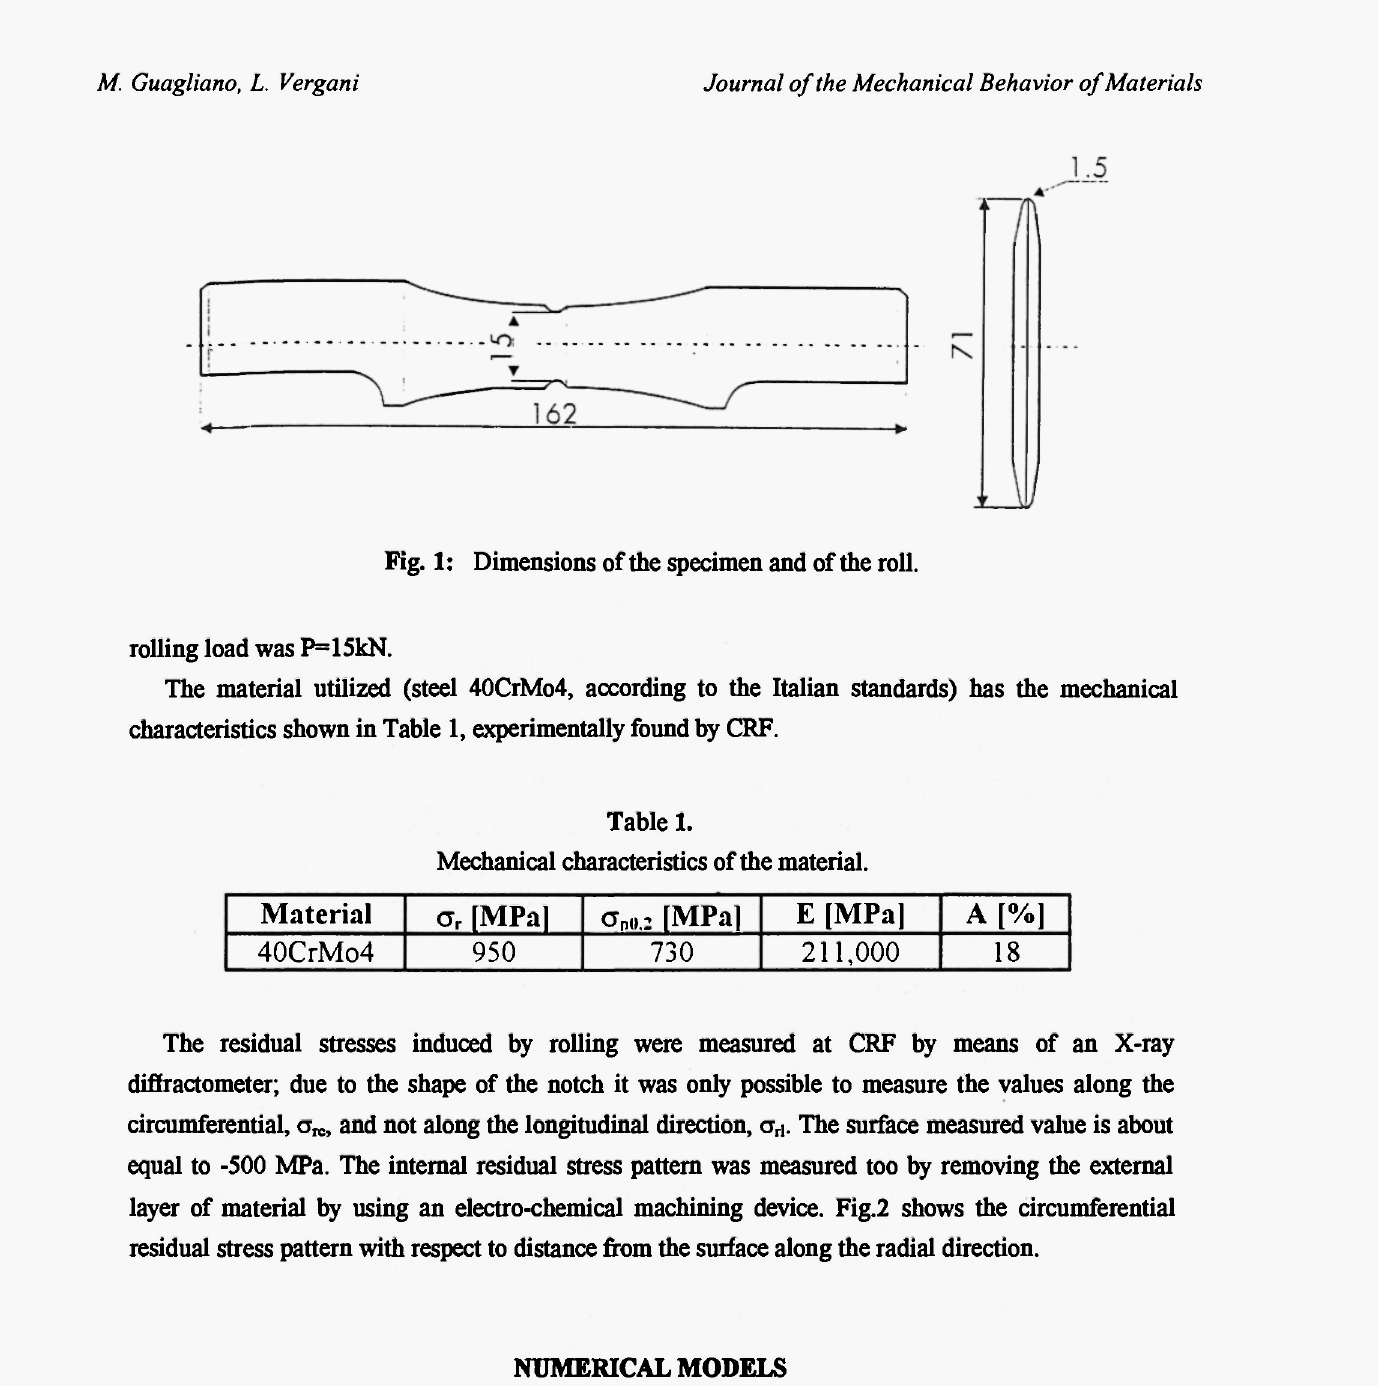
Mechanical characteristics of the